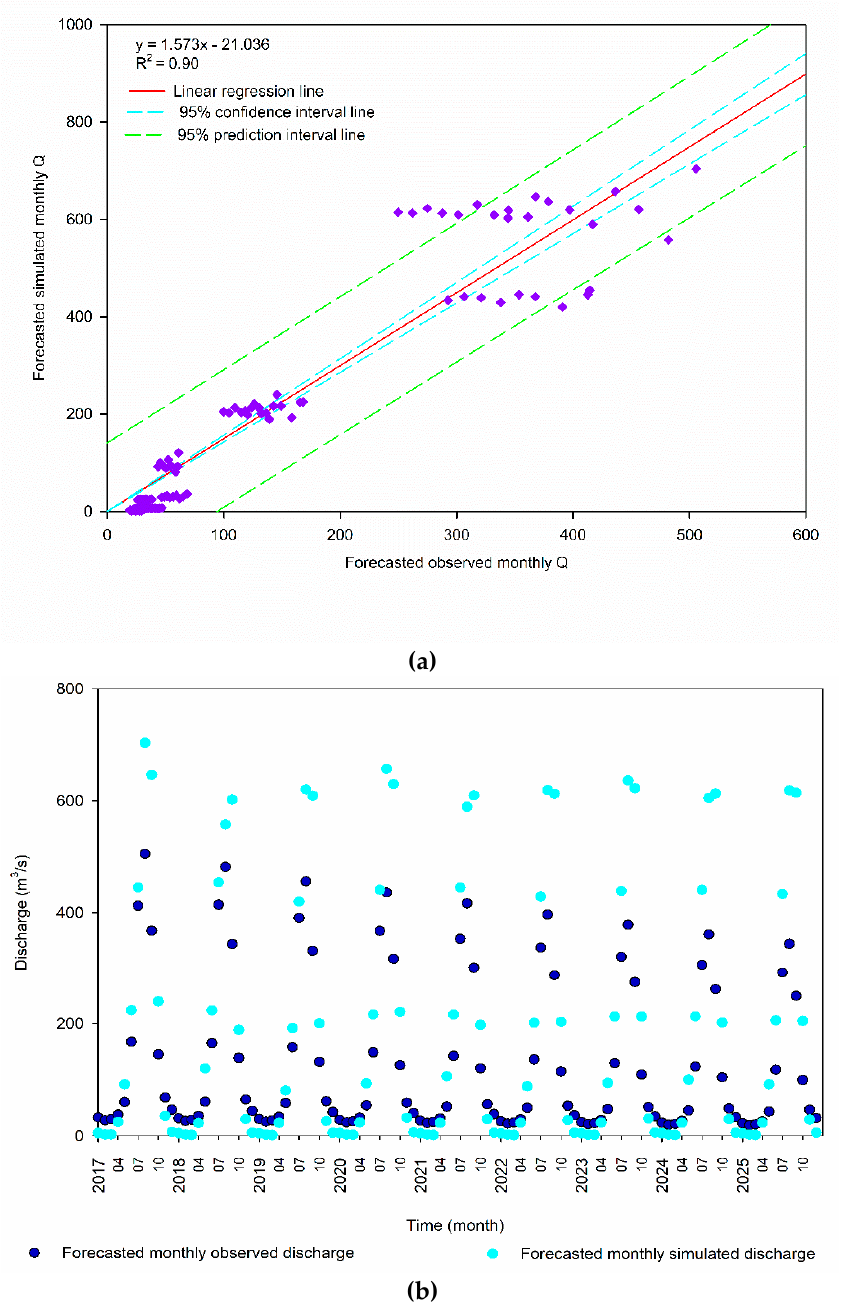
Figure 8. ( a ) Comparison between observation-based and SWAT-simulation-based Lhasa River forecasted flow from 2017 to 2025. ( b ) Scatter plot of observation-based and simulation-based forecasted monthly Lhasa River discharge for